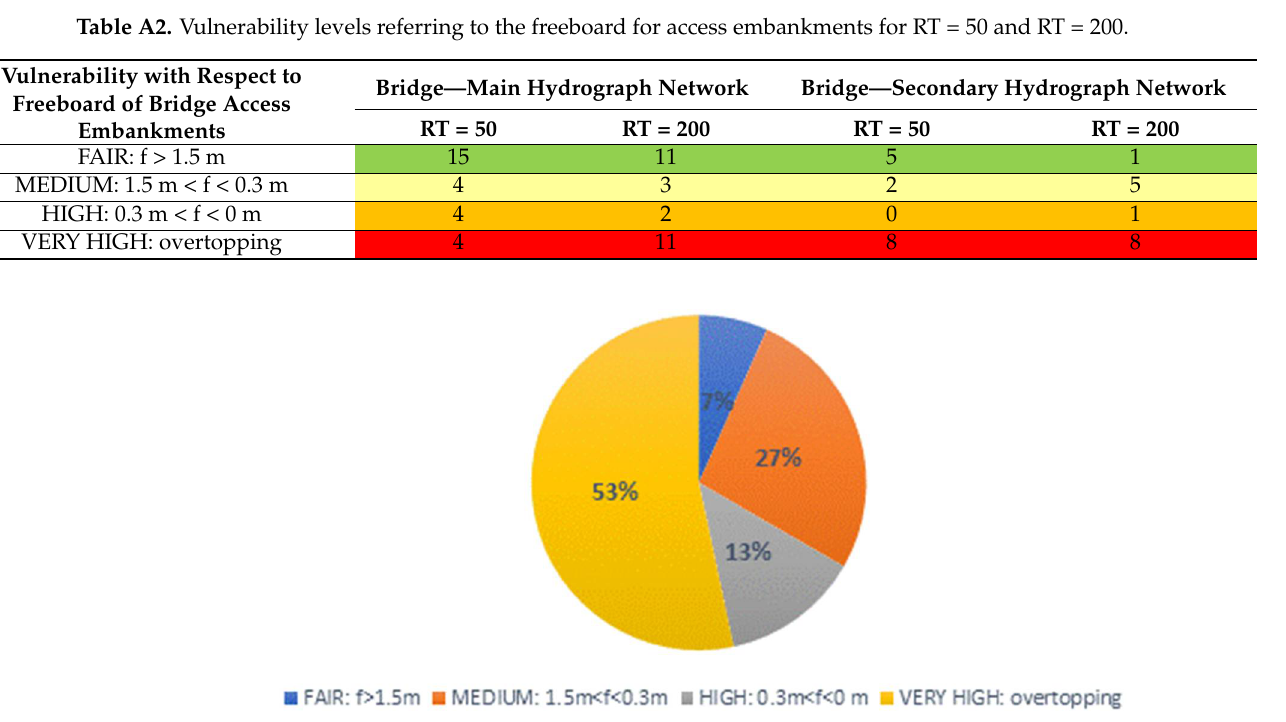
Figure A5. Distribution of vulnerability levels referring to the freeboard for road embankments, RT = 200.